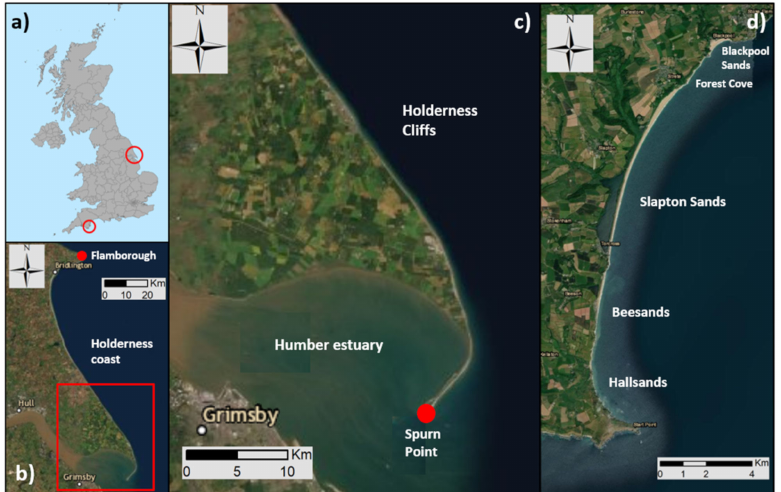
Figure 1. Location of study sites; ( a ) on a map of the UK, ( b ) the Holderness coast and the region of study, ( c ) Sites #1 & #2 correspond with Holderness Cliffs and Humber estuary separated by Spurn Point, ( d ) Site #3 with Start Bay barrier beach. Source of aerial imagery: Esri, Maxar, GeoEye, Earthstar Geographics, CNES/Airbus DS, USDA, USGS, AeroGRID, IGN, and the GIS User Community,